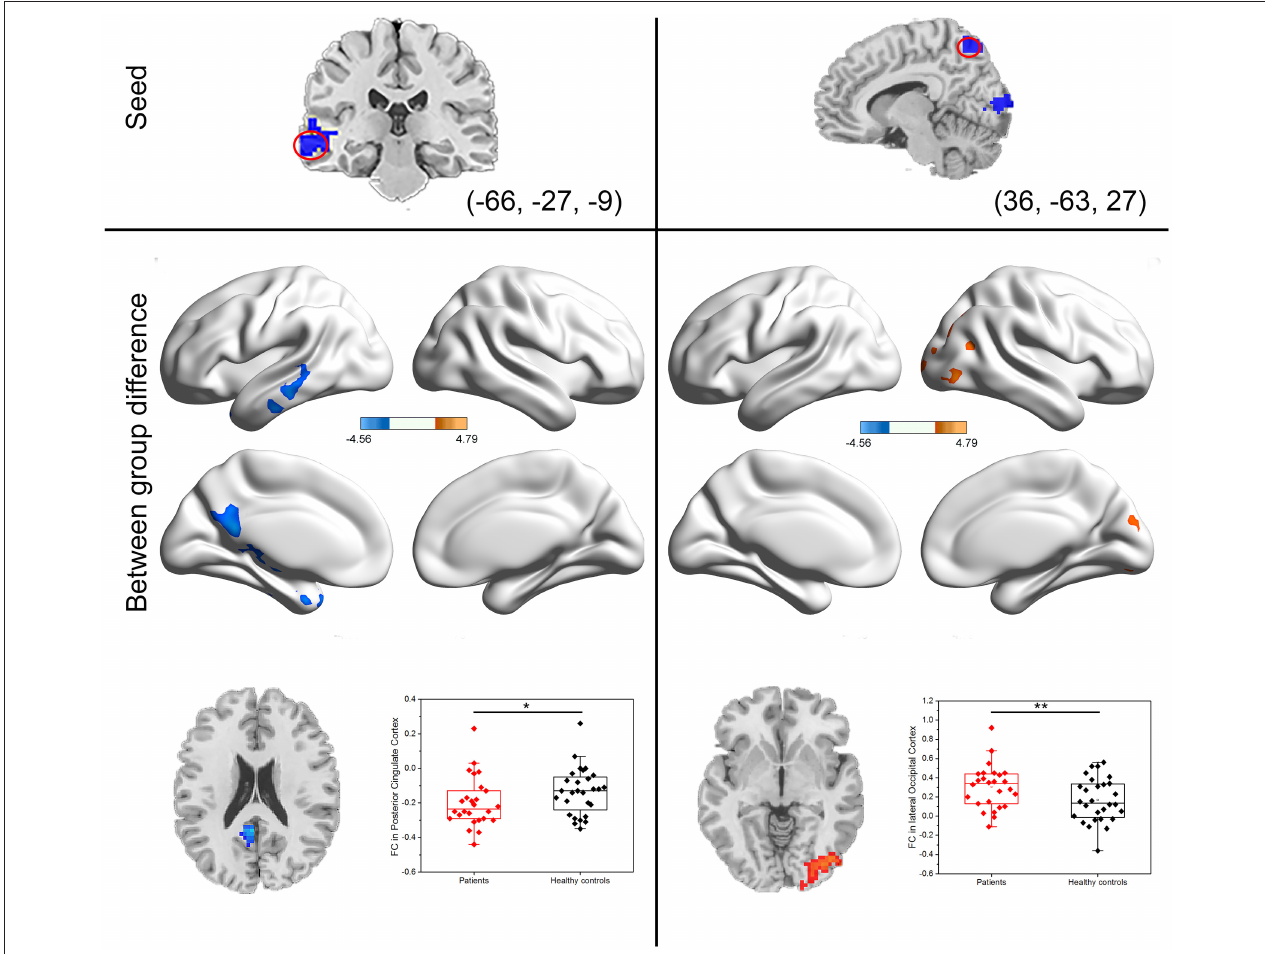
FIGURE 3 | Group differences in seed-based functional connectivity. The seeds were defined as left middle temporal gyrus and right precuneus. Scatter plot of FC for the significantly increased or decreased clusters between PI patients and healthy controls. Red dots: PI patients; black dots: healthy controls. Error bars represent standard deviation of the mean (* P < 0.05, ** P <